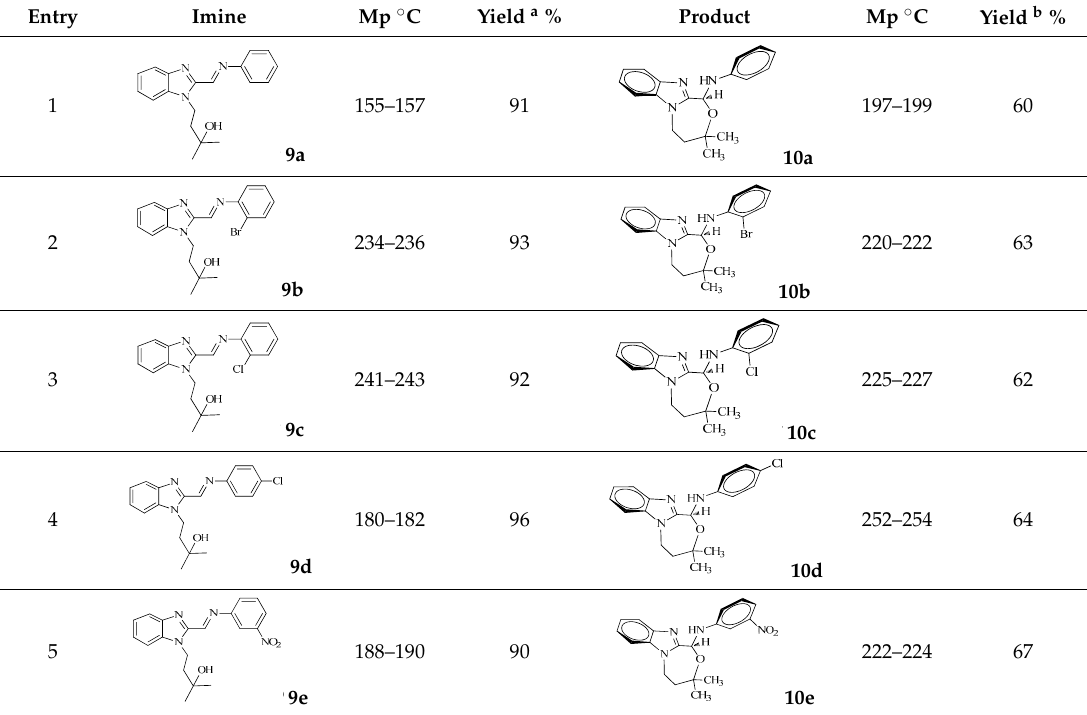
Figure 3. Diagram showing the ORTEP of 10b with partial disorder in one of the molecules.